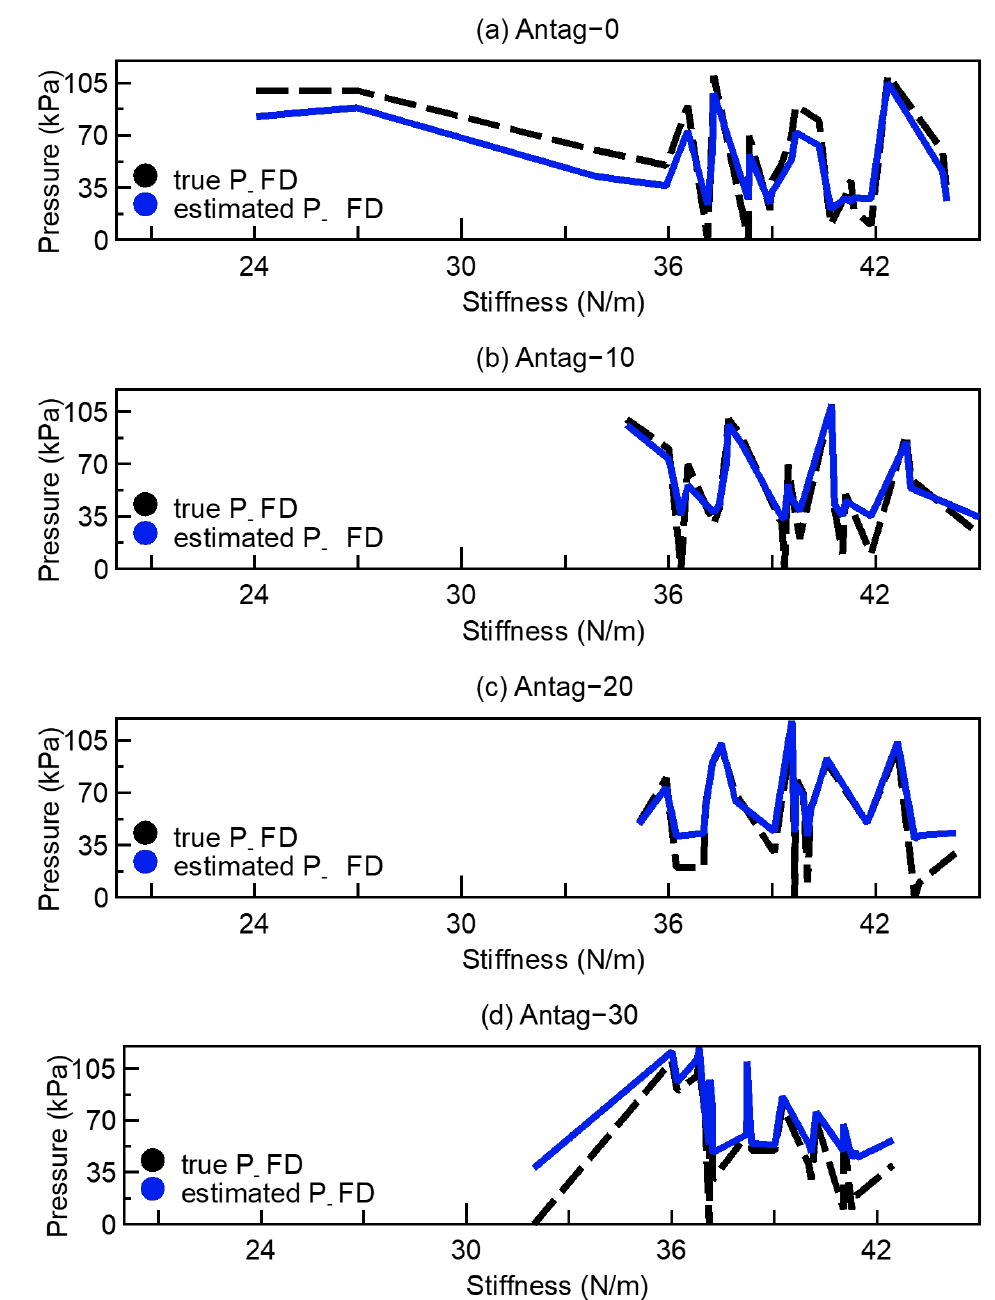
Figure 11. The test data of adjusting stiffness with 5.0 mm endoscope from NN ( a ) Antag − 0, ( b ) Antag − 10, ( c ) Antag − 20, ( d ) Antag − 30. ( b ) Antag − 10, ( c ) Antag − 20, ( d ) Antag −